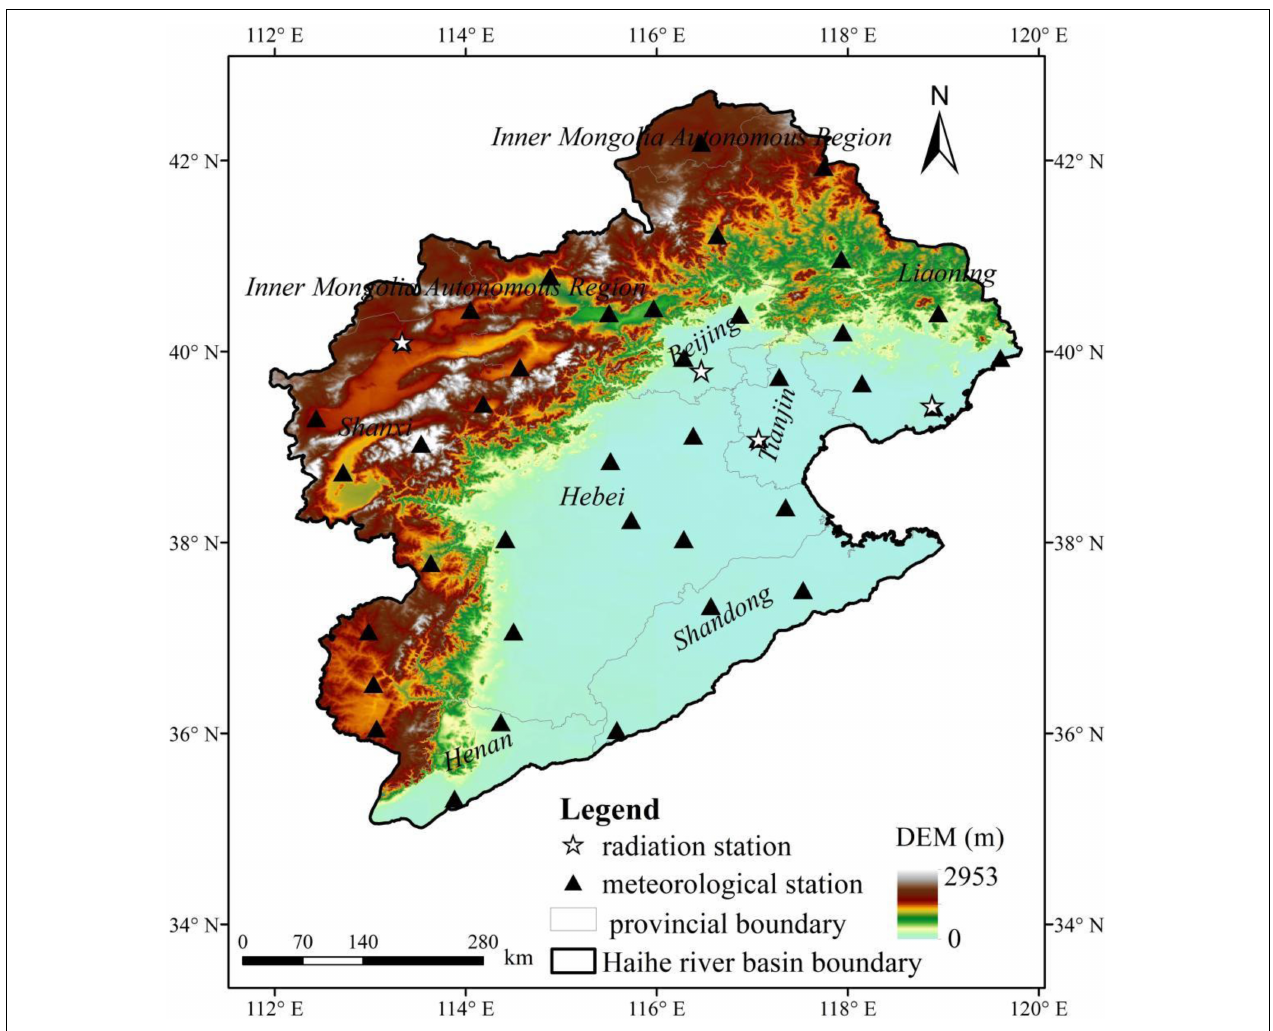
FIGURE 2 | Location of the meteorological and radiation stations in the Haihe River